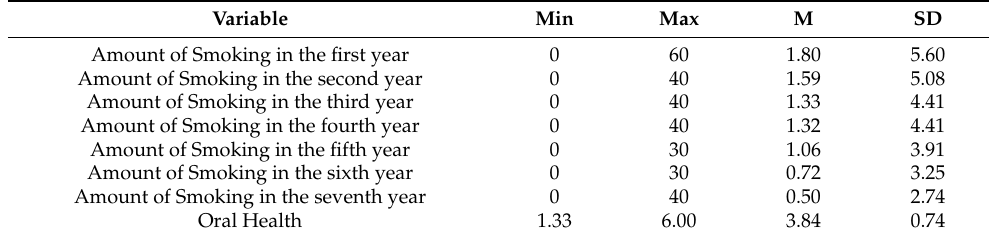
Table 1. Descriptive statistics ( n =